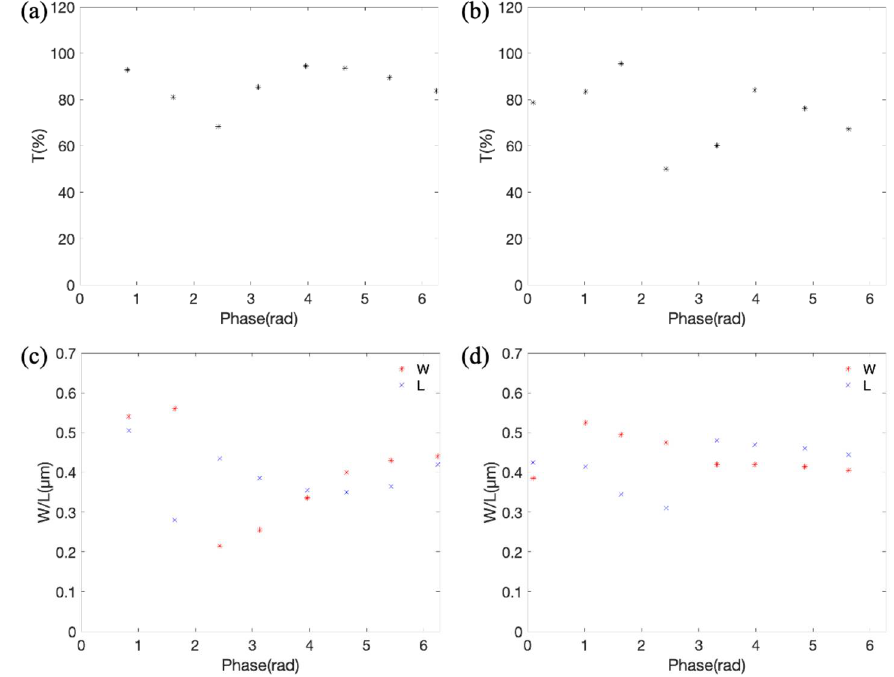
Figure 3. The eight unit-cells with nanobricks or nanoholes selected for constructing metalenses: The transmittance and phase difference of ( a ) Nanobricks and ( b ) Nanoholes. The widths and lengths of ( c ) Nanobricks and ( d ) Nanoholes.